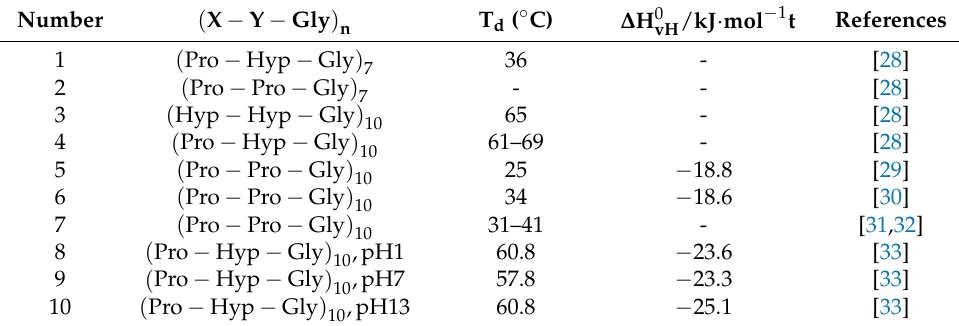
Table 5. Thermal denaturation data of collagen